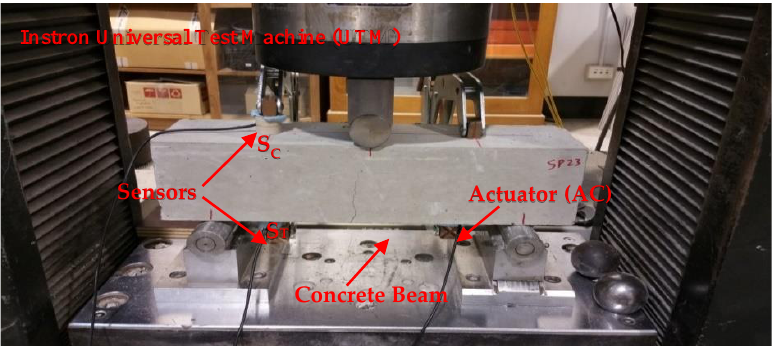
Figure 5. The three-point bending test, Center of Infrastructure Engineering (CIE), Western Sydney University.